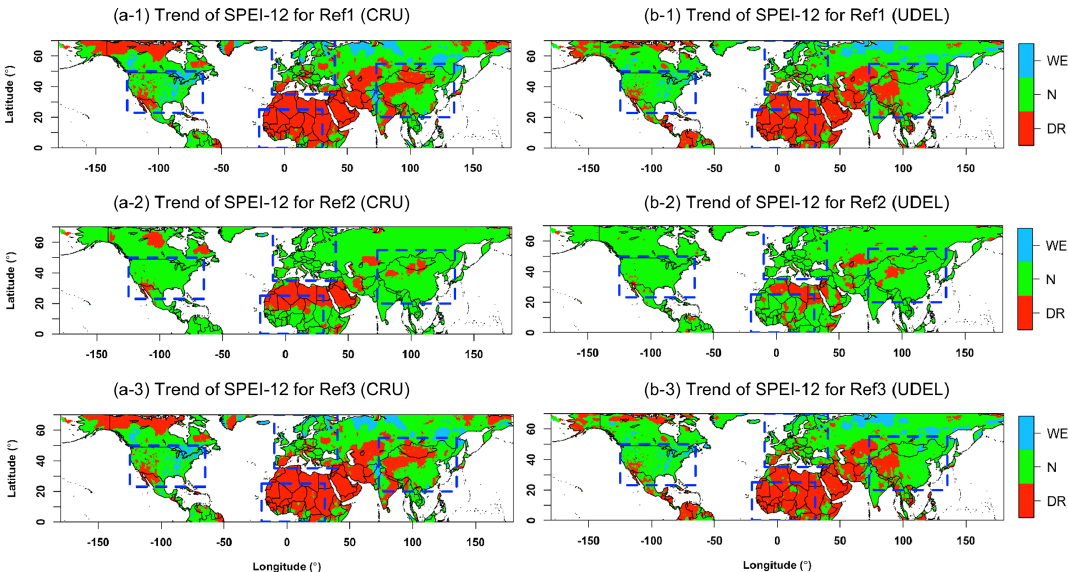
Figure 7. SPEI-12 trends in three different reference periods (Ref1, Ref2 and Ref3 in Table 2) based on the (a) CRU and (b) UDEL datasets. The colored regions correspond to regions of WE, N and DR, which denote a statistically positive (wetting) trend, no trend and a negative (drying) trend, respectively, at a significance level of